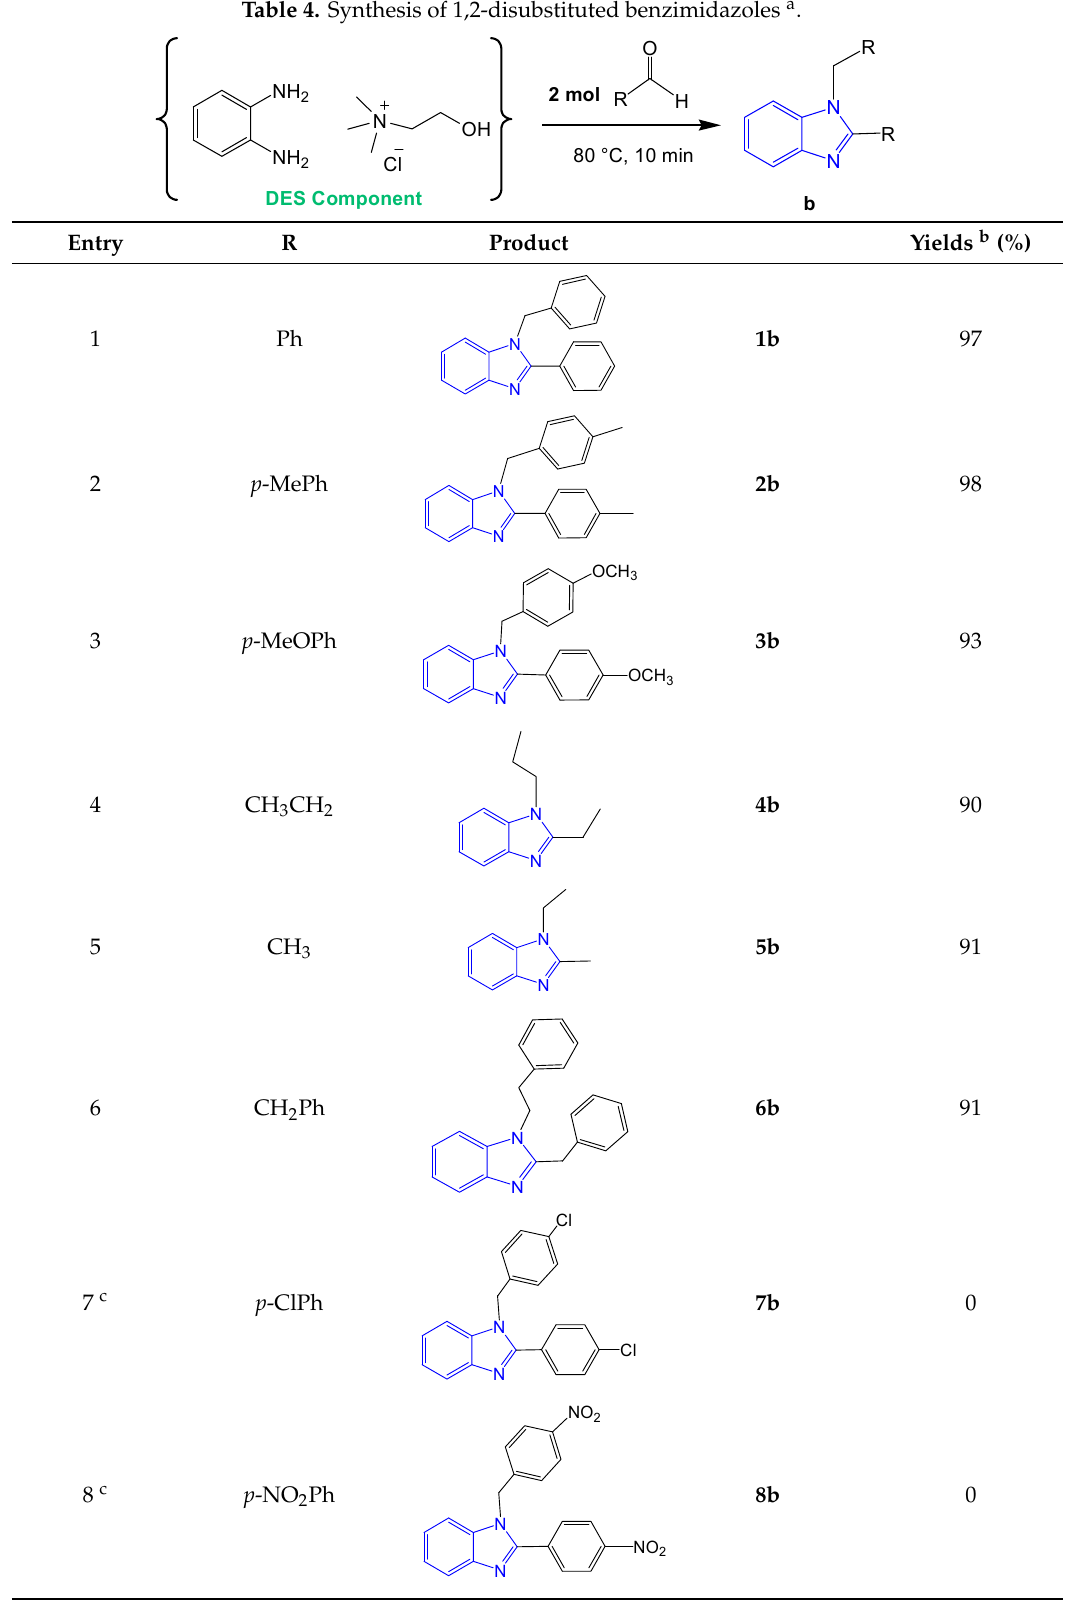
Table 4. Synthesis of 1,2-disubstituted benzimidazoles a .